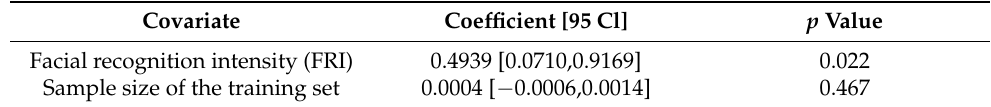
Table 2. Meta-regression between FRI, sample size of the training set, and ln(OR) of automatic diagnosis by facial recognition. FRI = facial recognition intensity, OR = diagnostic odds ratio. FRI and sample size of the training set were analyzed as covariates in a meta-regression model to explore the heterogeneity between studies. Their coefficient and 95% confidence interval in the model are shown with two-tailed probability of type I error of 0.05 ( α = 0.05).